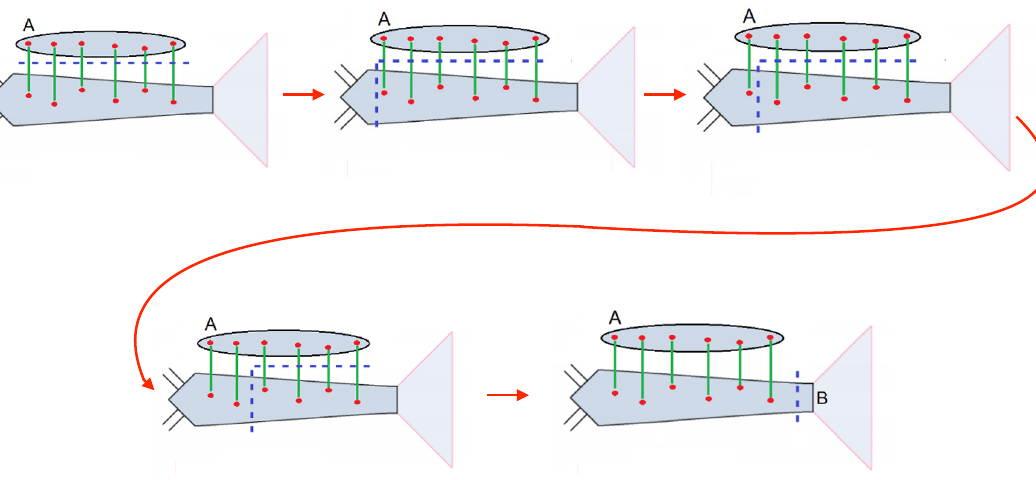
Figure 14 . A non-temporal sweep of spatial cuts through the expandable space blimp geometry of (cid:12)gure 13, analogous to the sweep of the spatial slices in (cid:12)gure 10. The next cut also cuts the entanglement between the interior and the (cid:15)